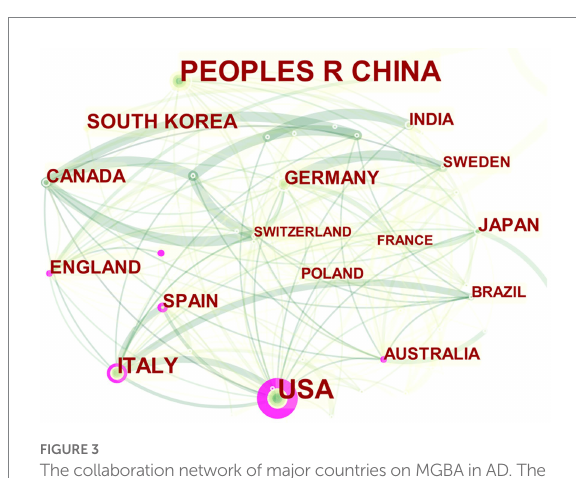
FIGURE 3 The collaboration network of major countries on MGBA in AD. The size of the nodes in the graph represents the number of publications in the country/region, and the thickness of the lines between nodes represents the strength of the relationship. The outer circle of a node is marked in purple, which means that the center degree of the node is >0.1, and the different colors of the inner circle and the connection line represent different years (for instance, dark cyan represents 2013–2014, green represents 2017– 2018, and pale yellow represents